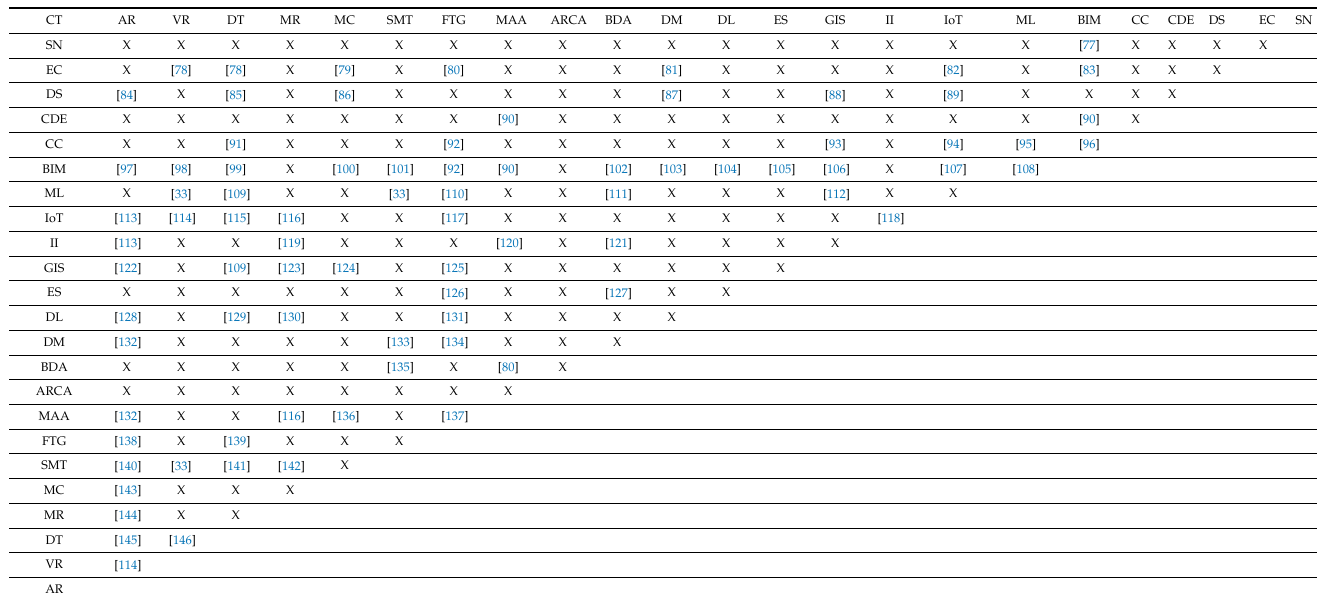
Table 9. Interoperability matrix among communication technologies and intra-CT